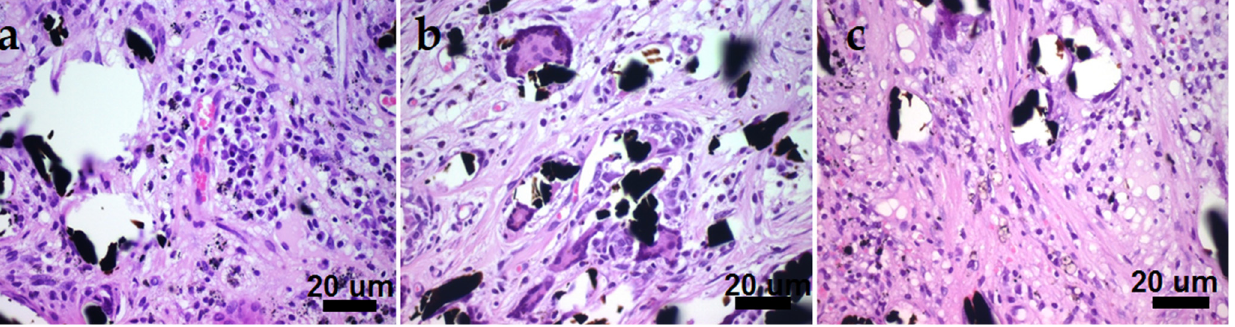
Figure 13. CCM sample micrographs demonstrating a large number of FBCs, macrophages, and lymphocytic cells (( a) —Pt/CCM sample, ( b )—Ag/CCM sample, ( c )—Au/Pt/CCM sample). The black inclusions are carbon fibers.